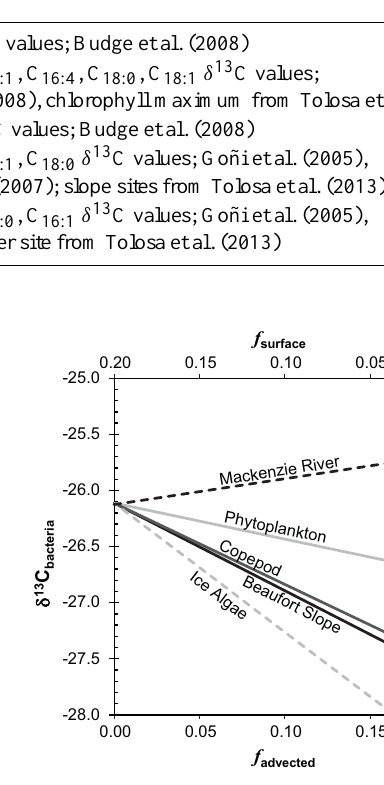
Fig. 6. Results of isotopic mass balance model for δ 13 C bacteria as a function of f advected between 1000 and 2500m depth. Each line represents a solution for isotopically distinct sources of advected or- ganic carbon with f surface plotted on the secondary horizontal axis and the fraction of chemoautotrophic vs. heterotrophic bacteria on the secondary vertical axis. f bacteria is